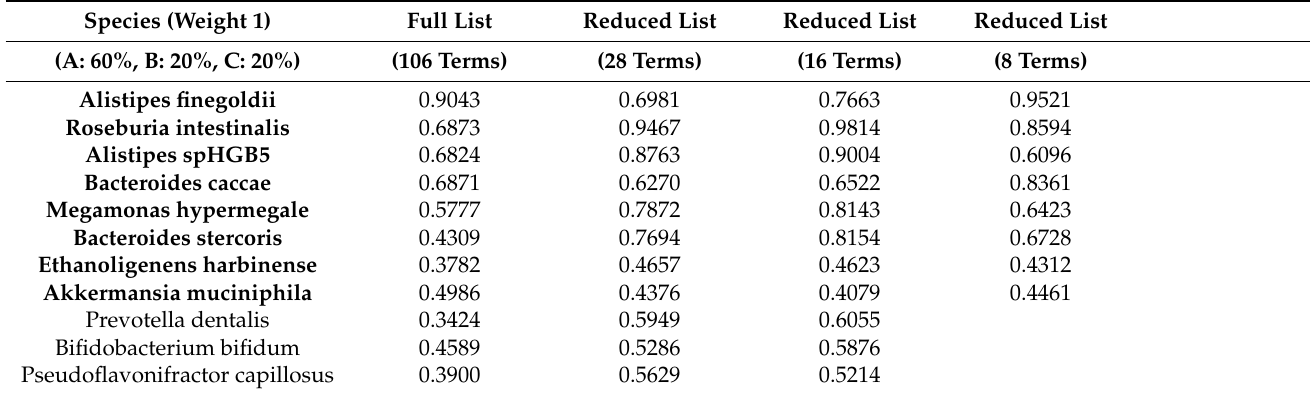
Table 4. Selection of species predictor variables using the Monte Carlo